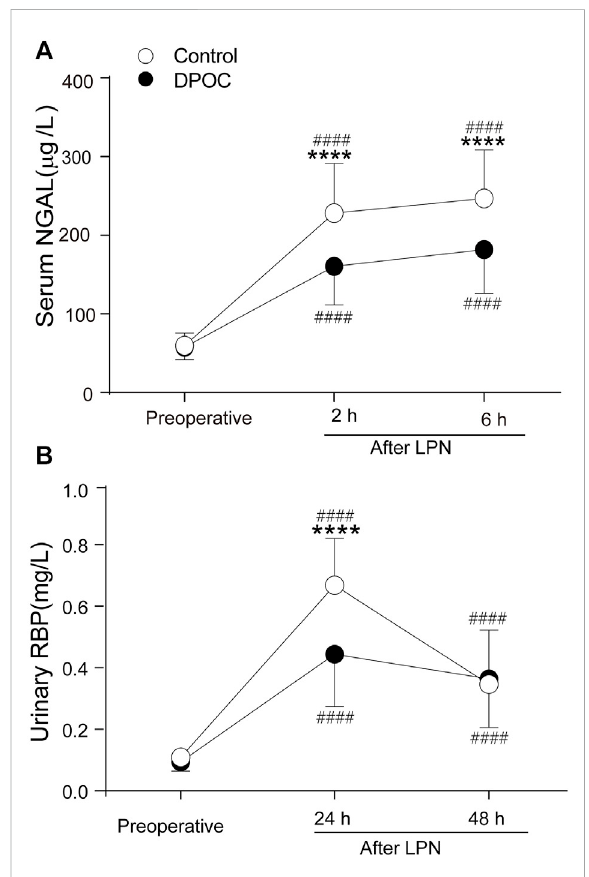
FIGURE 2 LevelsofserumNGAL (A) andurinaryRBP (B) beforeandafter surgery between DPOC or control group. **** p < 0.0001 vs. control group. #### p < 0.0001 vs. Baseline. NGAL = neutrophil gelatinase-associated lipocalin; RBP = Urinary retinol- binding protein; Control = Control group; DPOC = dexmedetomidine postconditioning